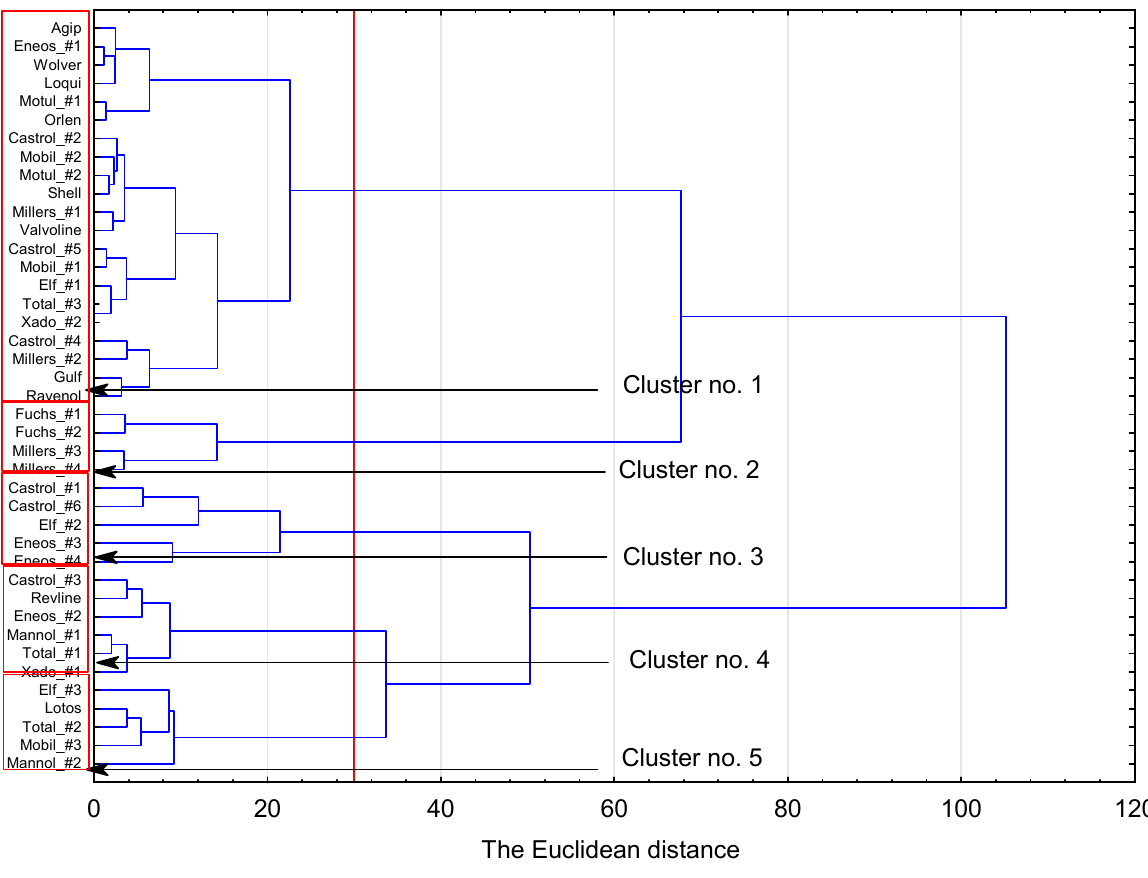
Figure 14. Agglomerative hierarchical clustering using Ward's linkage and Euclidean distance - based on all of the electrical parameters combined.